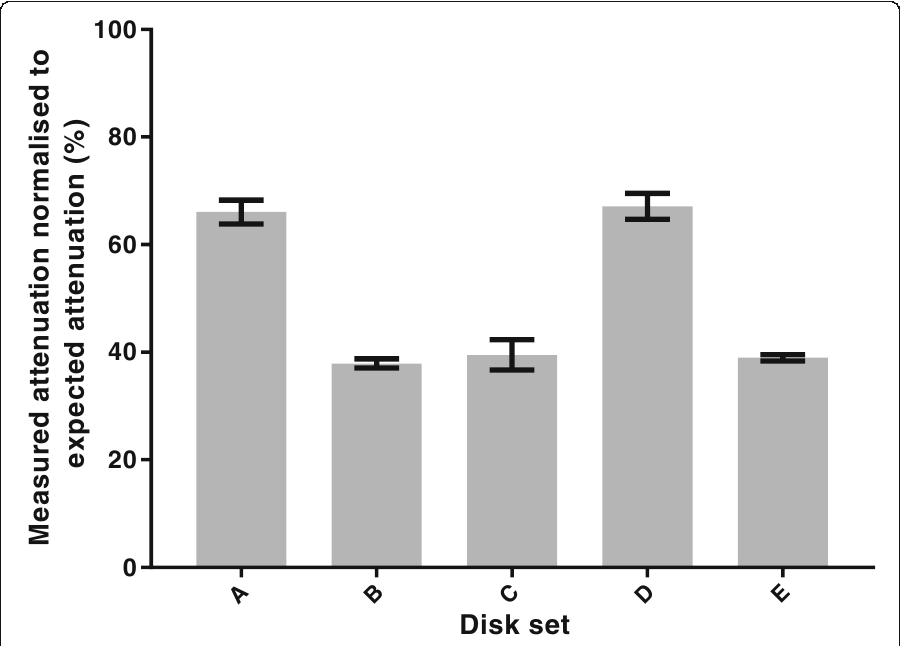
Fig. 7 Beam attenuation measured through 0.5-mm-thick disks produced with different scan strategies